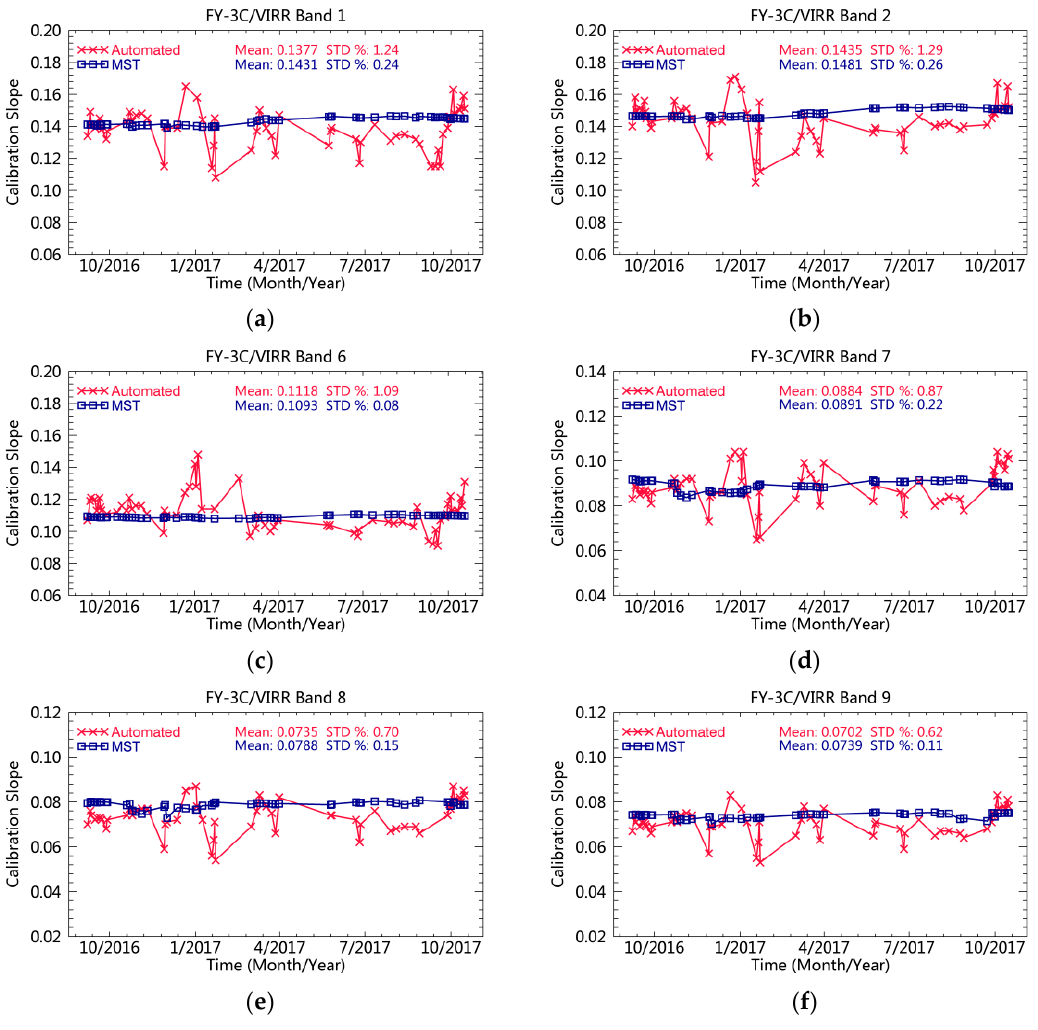
Figure 11. Time series of calibration slopes for the FY-3C VIRR from September 2016 to October 2017 derived from the MST and automatic calibration methods. ( a , b ) bands 1–2; ( c , d ) bands 6–7; ( e , f ) bands 8–9.